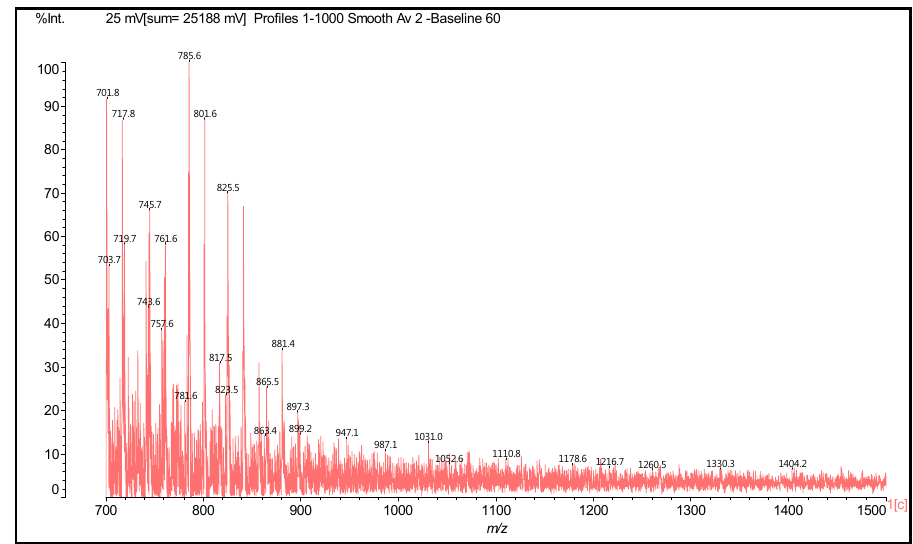
Figure 22. MALDI-ToF spectrum of the reaction of mimosa tannin extract with hexamethylene diamine at 100 °C, pTSA-catalysed. Range 350–700 Da.